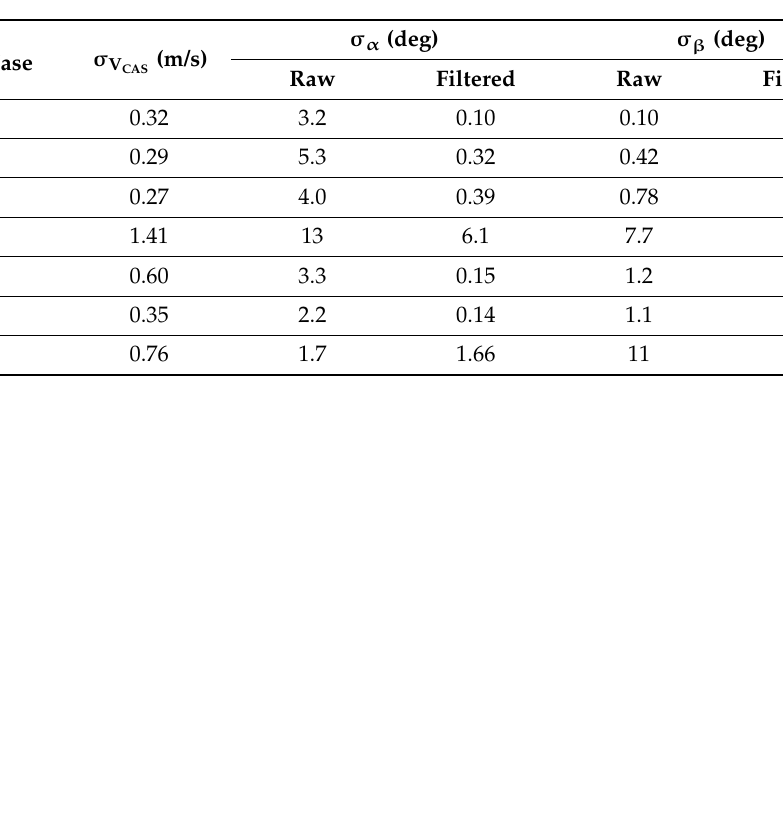
Table 7. Standard deviations of estimated CAS, AOA, and AOS (raw and filtered